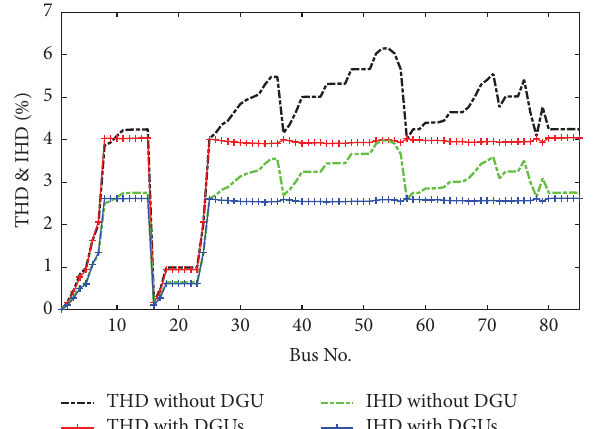
Figure 19: THD (%) and IHD (%) of the IEEE 85-bus system before and after DGUs connection.